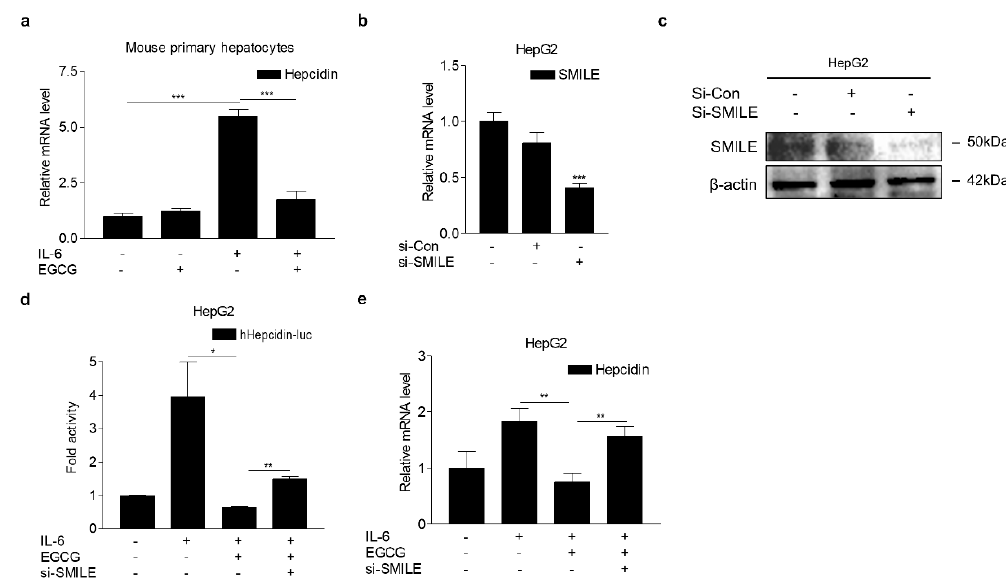
Figure 6. Effects of SMILE knockdown on inhibiting hepcidin expression by EGCG. ( a ) EGCG effect on IL-6-induced hepcidin expression in mouse primary hepatocytes treated with IL-6 (20 ng/mL) and EGCG (100 μ M) for 12 h. ( b ) Q-PCR analysis showing efficiency of SMILE knockdown. HepG2 cells were transfected with si-Con and si-SMILE for 48 h. ( c ) Western blot analysis showing efficiency of SMILE knockdown. HepG2 cells were transfected with si-Con and si-SMILE for 66 h. ( d ) Transient transfection analysis showing the effect of SMILE knockdown on EGCG-reduced hepcidin promoter activity. HepG2 cells were transfected with Hepcidin-luc (200 ng) and si-SMILE and then treated with IL-6 (20 ng/mL) and EGCG (100 μ M) for 12 h. ( e ) Q-PCR analysis showing SMILE knockdown effect on EGCG-mediated inhibition of hepcidin expression. HepG2 cells were transfected with si-SMILE and then treated with IL-6 (20 ng/mL) and EGCG (100 μ M) for 12 h. The independent experiments were repeated at least twice. The values are presented as means ± SD. * P < 0.05, ** P < 0.01, *** P < 0.001 using two-tailed Student’s t -test.